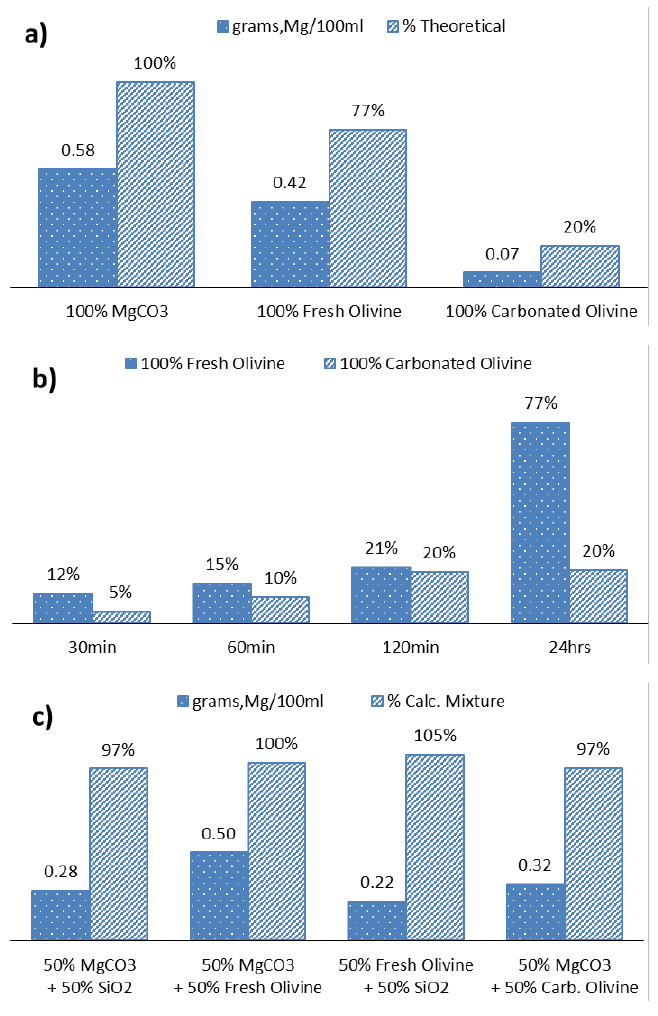
Figure 11. ( a ) leaching extent (in 1.28 N H 2 SO 4 , 2 g/100 mL, 24 h) from pure magnesium carbonate, fresh olivine and carbonated olivine; ( b ) leaching extent (in 1.28 N H 2 SO 4 , 2 g/100 mL) from fresh olivine and carbonated olivine as a function of time; ( c ) leaching extent (in 1.28 N H 2 SO 4 , 2 g/100 mL, 24 h) from mixtures of pure magnesium carbonate, pure silica, fresh olivine and carbonated